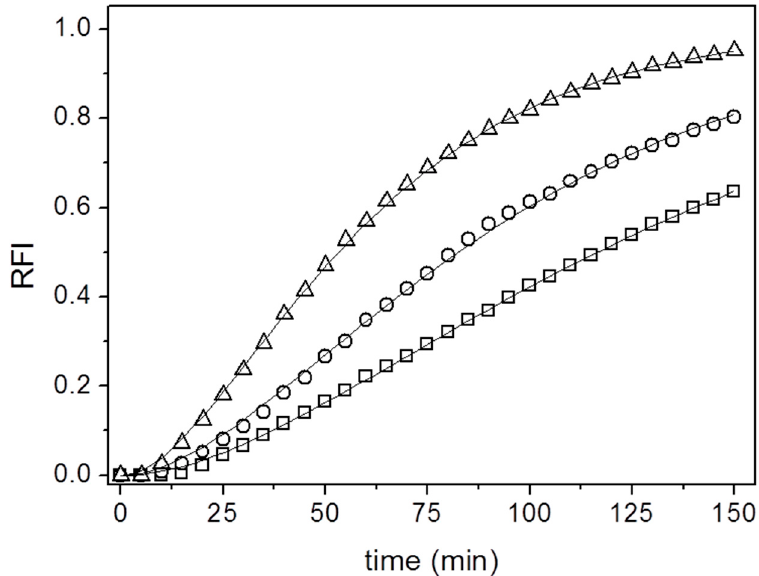
Figure 9. Relative fluorescence intensity obtained from lipase hydrolysis of QDA 2.0 × 10 − 5 mol ∙ L − 1 in 3 mL of decaline as a function of reaction time and amount of supported lipase added converted to enzyme mass ( □ ) 0.7 mg, ( ○ ) 1.5 mg, ( Δ ) 2.2 mg. The line curves are the fitting of the data with Equation